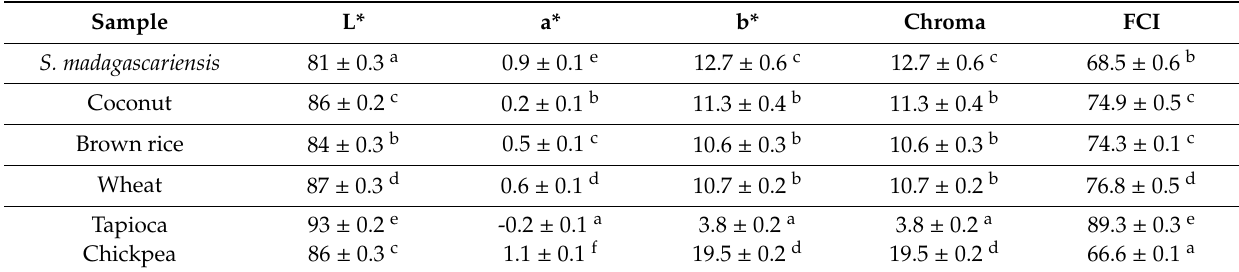
Table 4. Colour properties of the Strychnos madagascariensis seed flour compared to the five reference